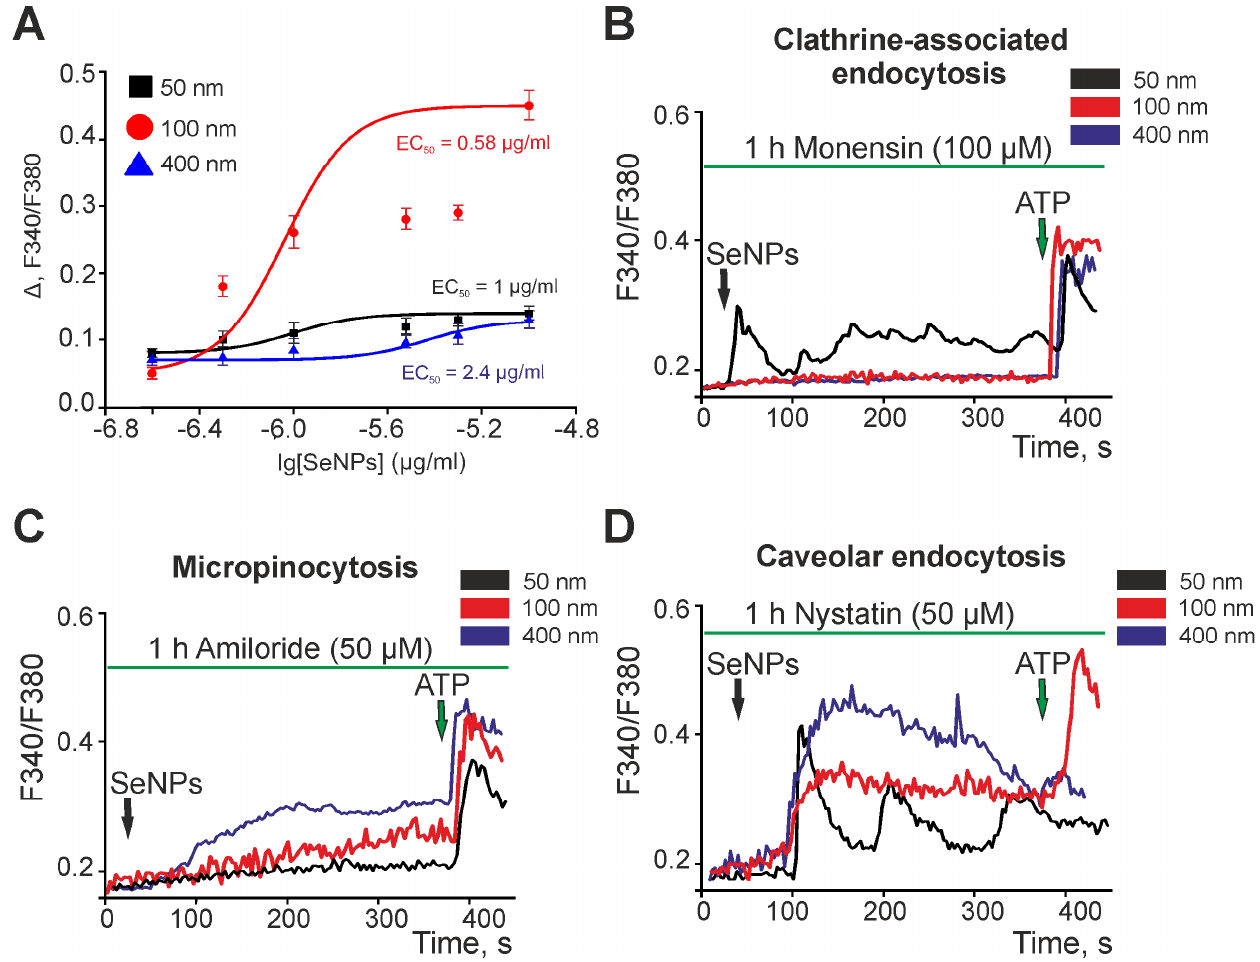
Figure 4. Activation of the Ca 2+ signaling system of cortical astrocytes by different-sized SeNPs involves different pathways of endocytosis. ( A )—Dependence of the amplitude of Ca 2+ responses of astrocytes on the growth concentration of different-sized SeNPs and its approximation by a sigmoid function. ( B – D )—Contribution of clathrin-associated endocytosis ( B ), micropinocytosis ( C ), and caveolar endocytosis ( D ) to the generation of Ca 2+ signals in astrocytes upon application of 3 μ g/mL different-sized SeNPs.